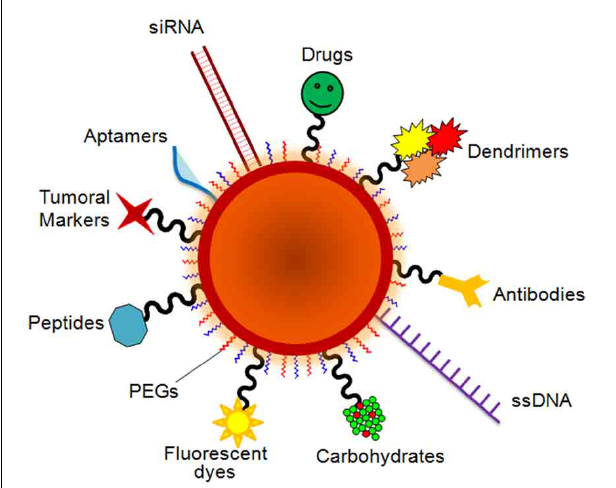
FIGURE 1 | Schematic representation of a multifunctional nanocarrier. These innovative NPs comprise nucleic acids such as RNA and DNA used for gene silencing approaches and in colorimetric assays, respectively. Aptamers and anticancer drug molecules are also used for delivery to the target tissue. Carbohydrates may be useful as sensitive colorimetric probes. PEG is used to improve solubility and decrease immunogenicity. Responsive nanocarriers can also trigger reaction upon external stimuli through the functionality of valuable tumor markers, peptides, carbohydrates, polymers and antibodies that can be used to improve nanocarrier circulation, effectiveness, and selectivity. Multifunctional systems can also carry fluorescent dyes that are used as reporter molecules tethered to the particle surface and employed as tracking and/or contrast